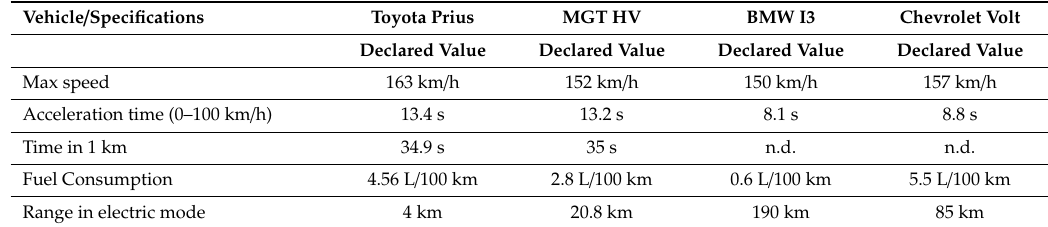
Table 29. Vehicles